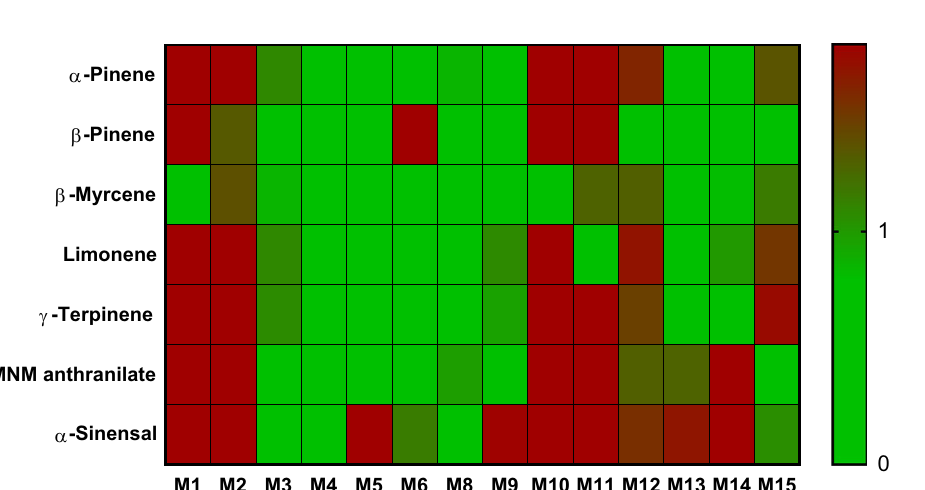
Figure 4. Heat map of relative scores of neroli essential oils for relevant compounds according to ISO 3517. N9 and N10 were obtain from a reputable source.